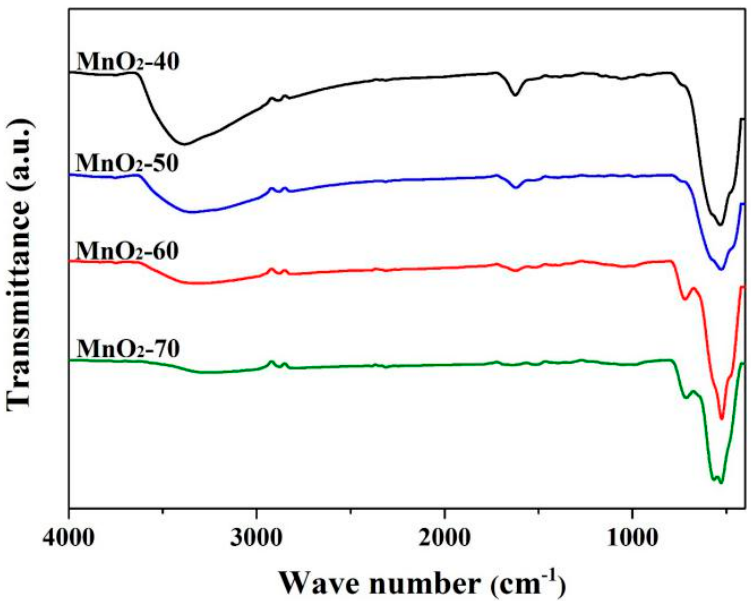
Figure 3. Fourier transform infrared (FTIR) spectra of MnO 2 prepared at different temperatures.